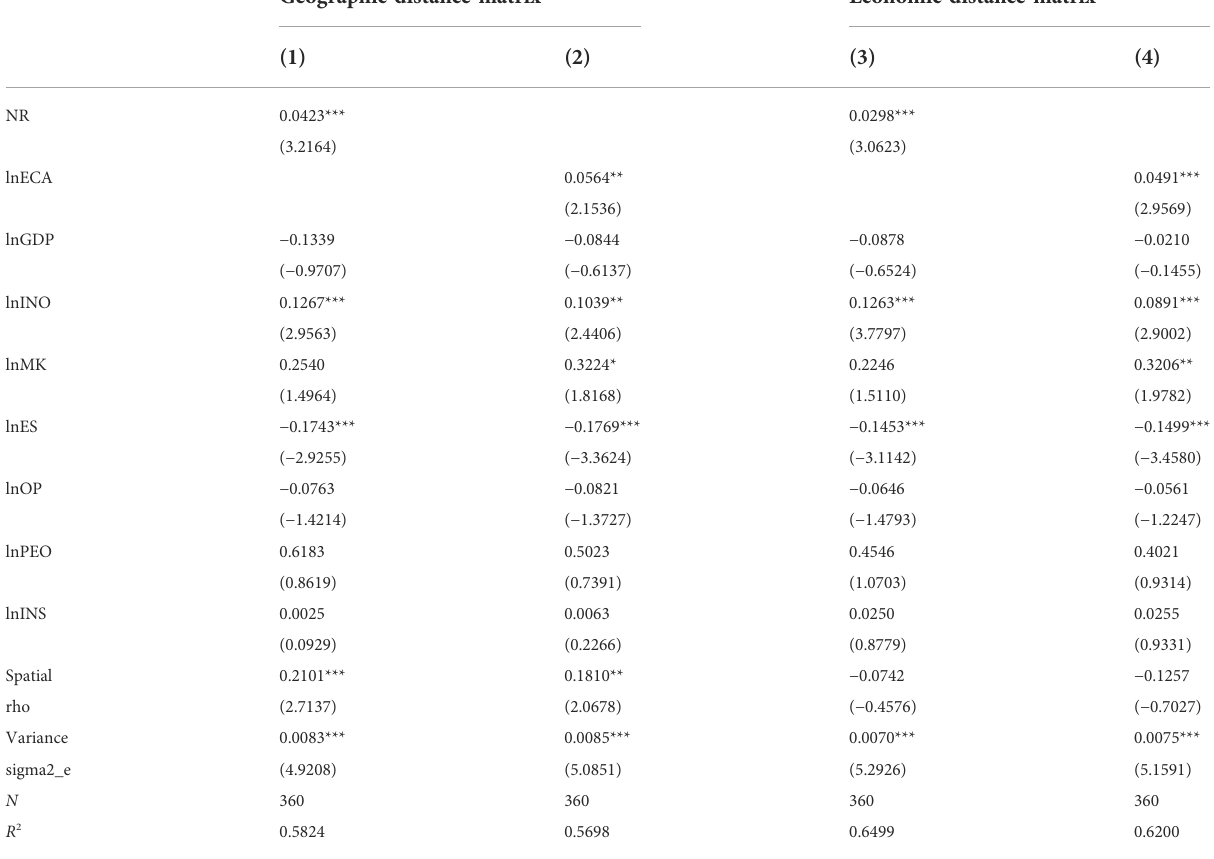
TABLE 5 Estimation results of energy endowment and energy capacity aggregation. Geographic distance